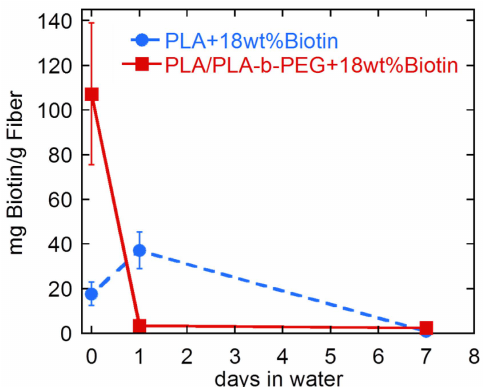
Figure 7. Surface available biotin of PLA and PLA/PLA- b -PEG fibers containing 18 wt % of biotin after being immersed in water for different periods of time.